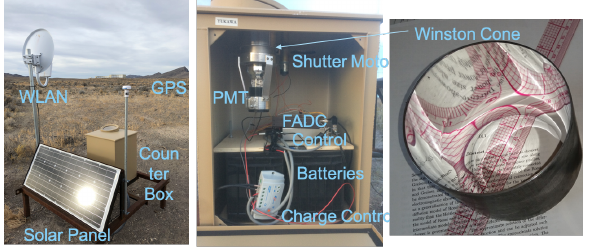
Figure 1. Left: NICHE counter from the outside. Middle: NICHE counter from the inside. Right: A Winston cone for NICHE.